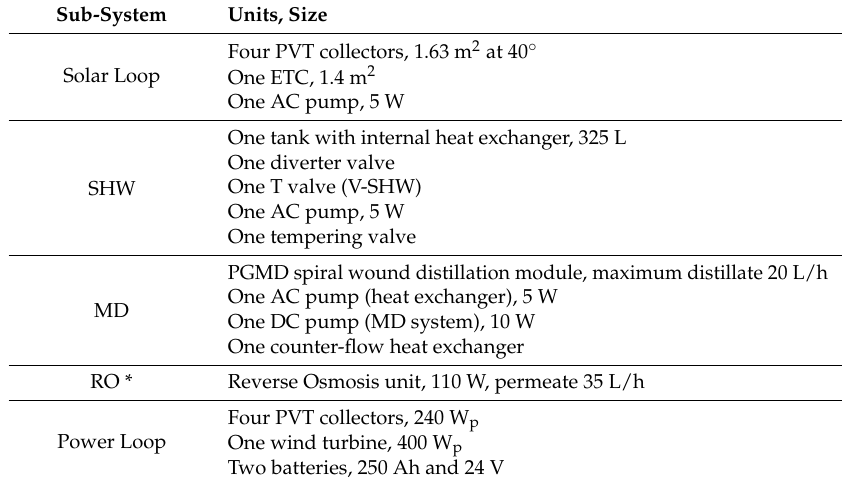
Table 4. Subsystems simulated in TRNSYS ® . * (RO was not modeled as a new